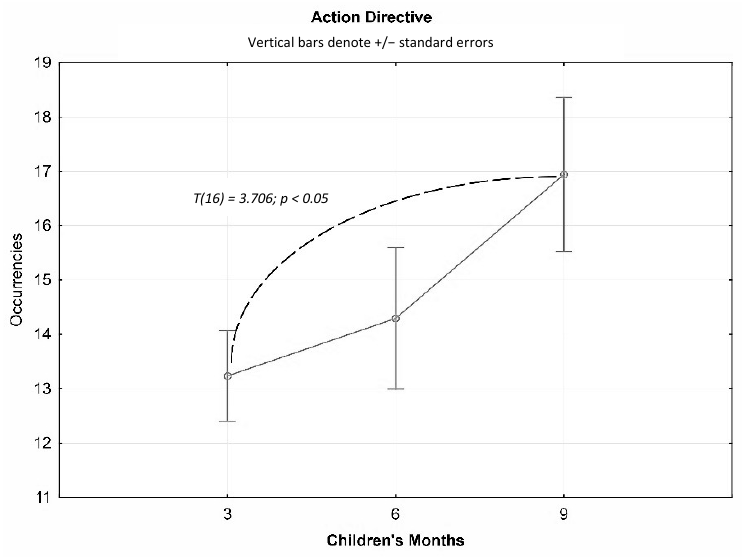
Figure 6. T -test average occurrences of the Action Directive at three, six, and nine months. Open Option and Explain behaviors remained unchanged between three, six, and nine months.